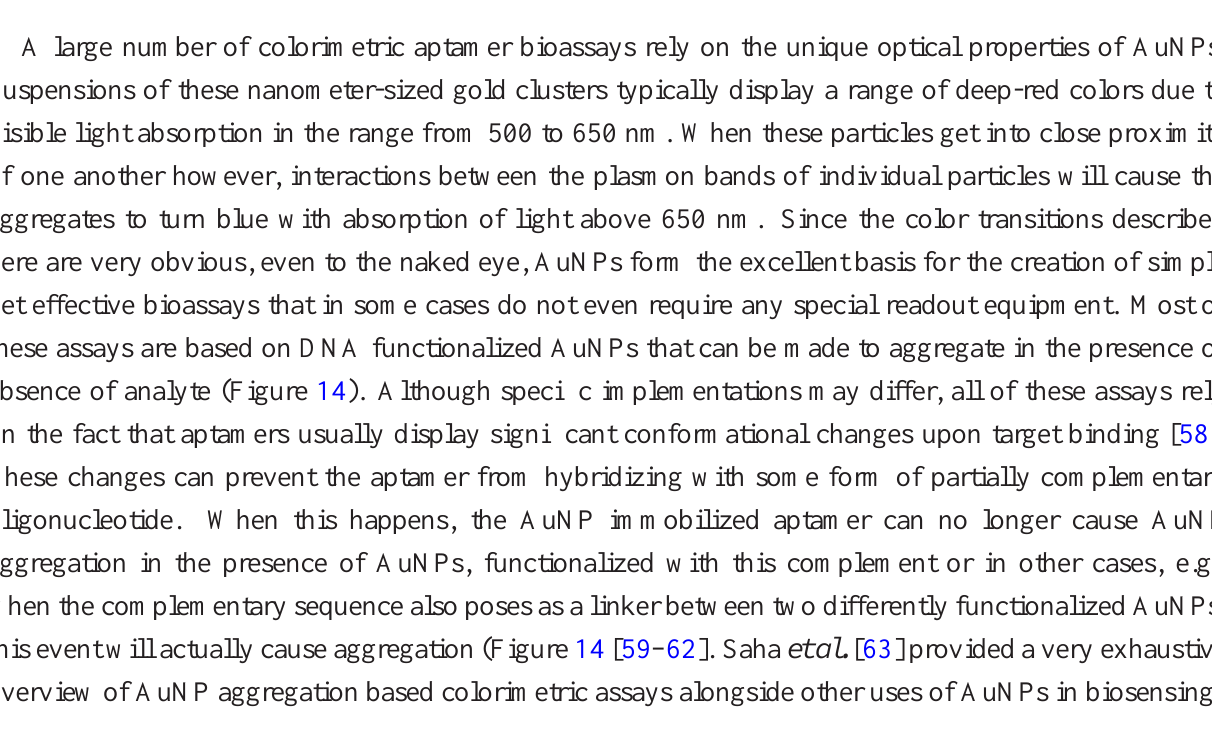
AuNP nanoparticle based protein detection strategies. ( A ) Target induced aptamer release resulting in AuNP aggregation. ( B ) Target induced aggregate breakup. Both approaches make use of the fact AuNP aggregation induces a coupling of their plasmon bands that leads to a color change from red to